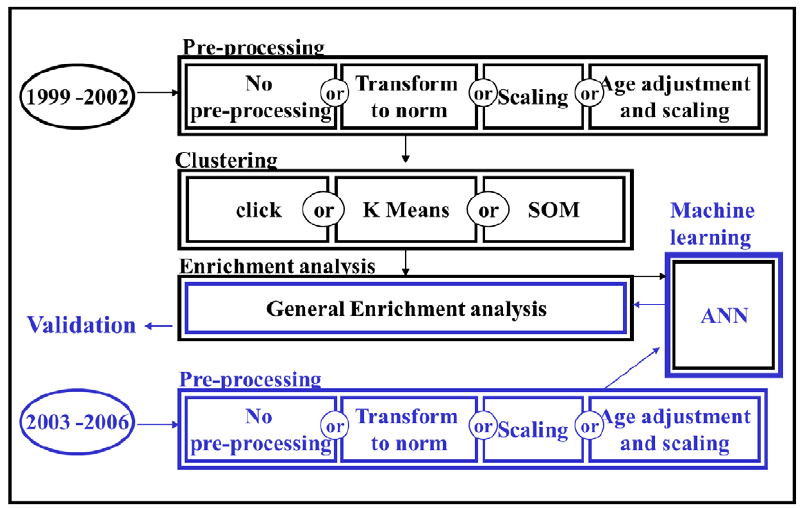
Figure 1. Methodology overview. A test-validation approach was used to test the impact of methodological choices on the clustering of individuals according to their classical blood biomedical marker values. The data from the NHANES 1999–2002 surveys was used as a training set, while the 2003–2006 dataset was used for validation. Various combinations of pre-processing and clustering algorithms were used to define clusters from the training set (black). For pre-processing (top row), transformation to normal of otherwise non-normal variables, Z-score normalized and Z- score normalized-with age adjustment using linear regression, were considered (top block). Each resulting dataset was clustered with three different clustering algorithms (second row): CLICK [18], K-means [21] and self-organizing maps [22]. The resulting clusters were used for enrichment analysis with health/lifestyle traits and for training an artificial neural network (third row). The artificial neural network was subsequently used to assign individuals from the validation set to clusters (third row), using the same pre-processing procedure as used to generate the training set clusters (bottom row). The resulting validation set clusters were also tested for enrichment with the same health/life-style traits as the training set. Enrichments found in both sets were